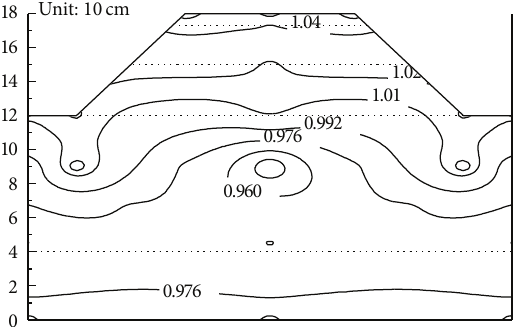
Figure 5: Values of response acceleration amplitude.